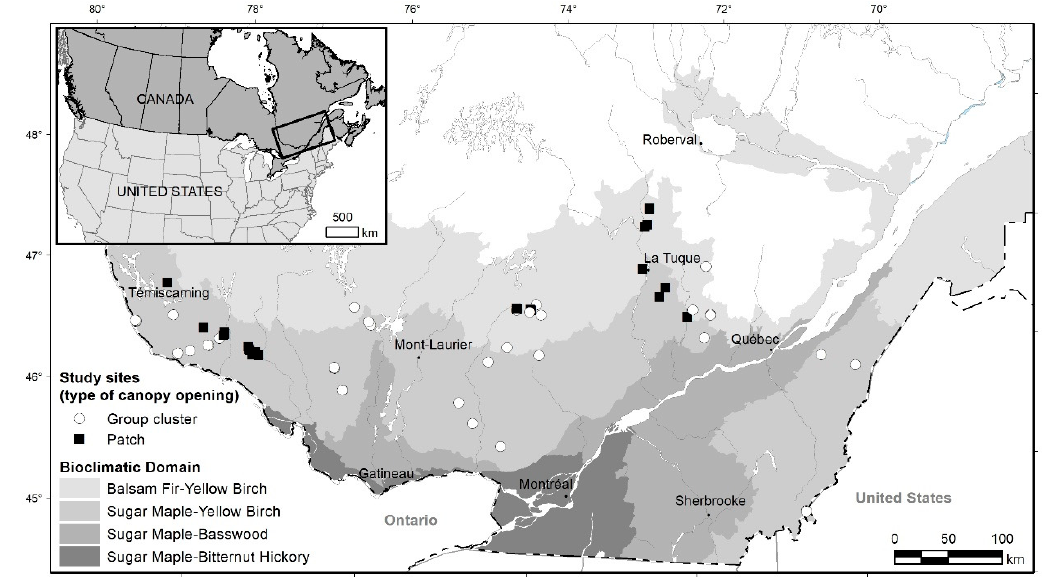
Figure 1. Location of study sites within the province of Quebec, Canada.